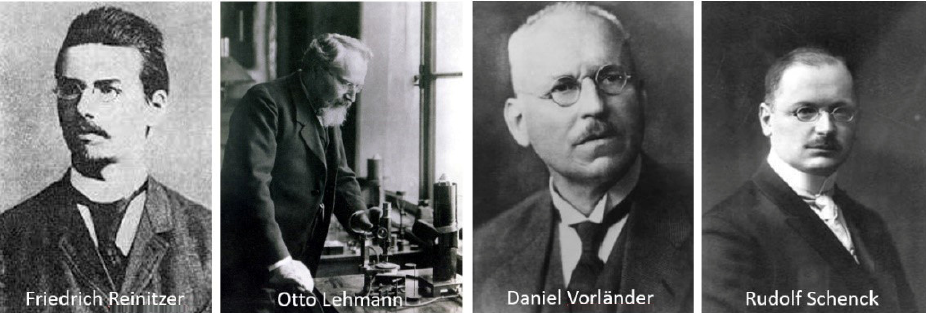
Figure 1. The German liquid crystal researchers of the early days: Friedrich Reinitzer, Otto Lehmann, Daniel Vorländer, and Rudolf Schenk.